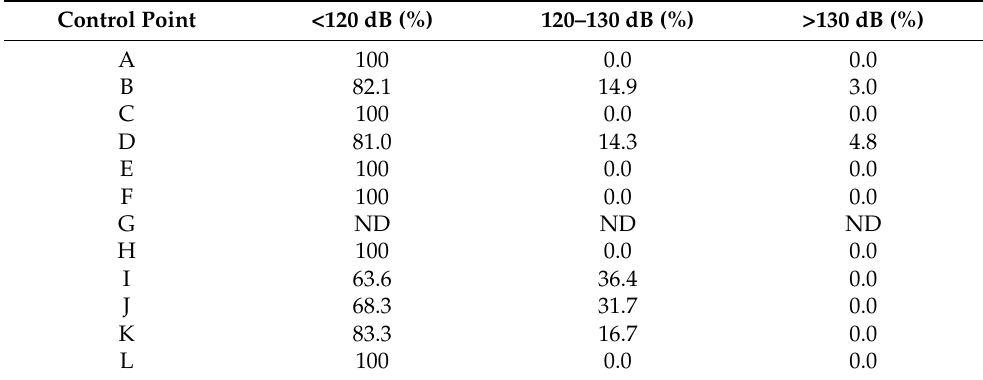
Table 6. Analysis of the air blasts recorded.